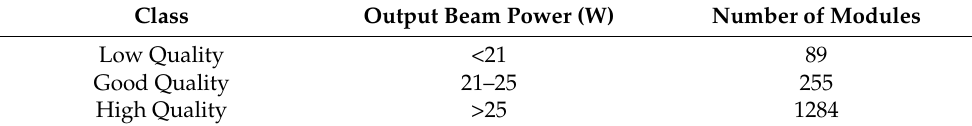
Table 5. New classification of the s-serie laser modules based on their output power.